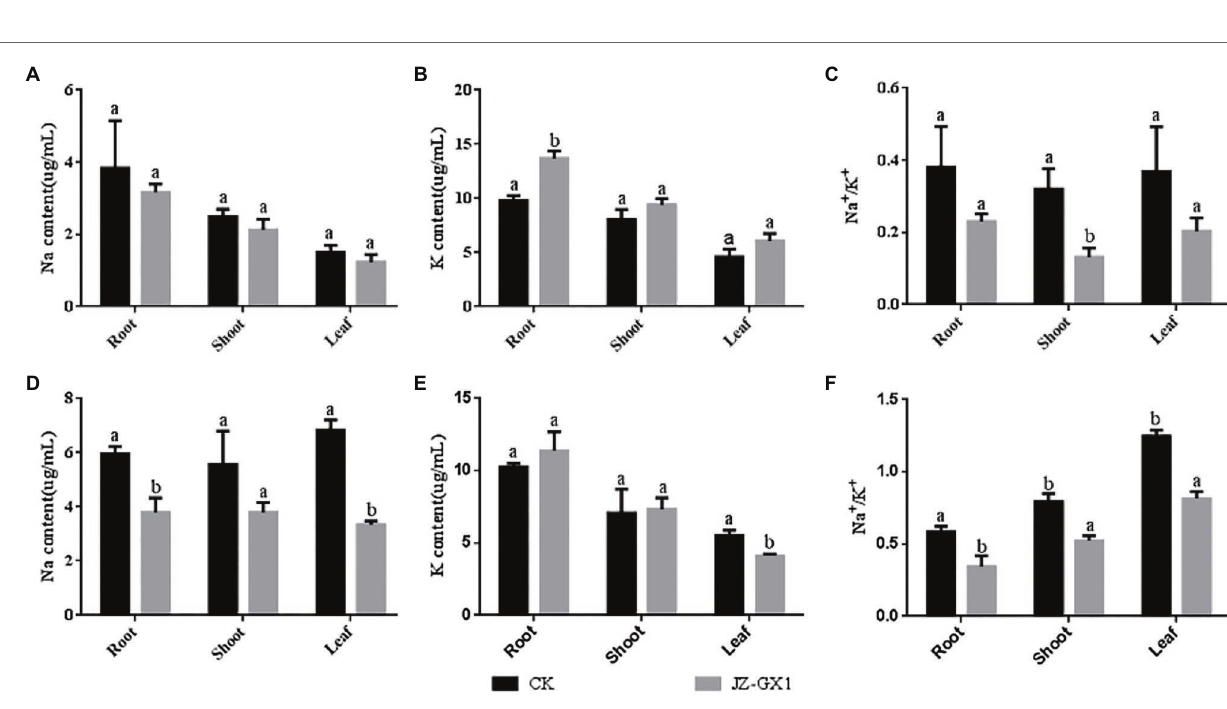
FIGURE 4 | Effect of volatile gases produced by R. aquatilis JZ-GX1 on the distribution of Na + and K + contents in R. pseudoacacia . (A) 0 mm Na + content; (B) 0 mm K + content; (C) 0 mm Na + /K + ; (D) 100 mm Na + content; (E) 100 mm K + content; (F) 100 mm Na + /K +